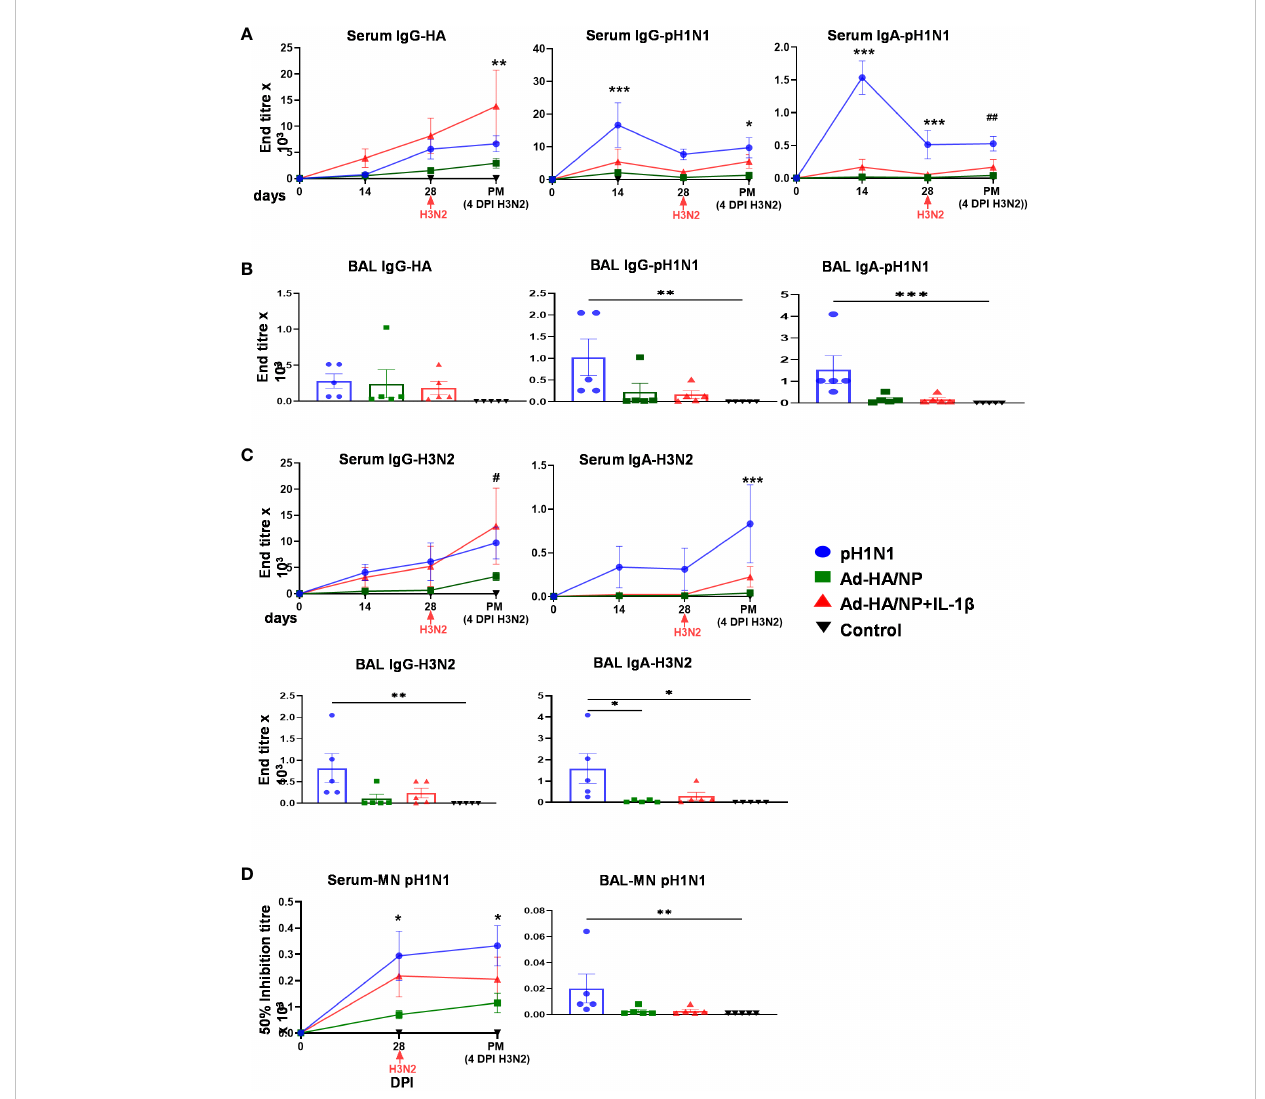
FIGURE 6 Antibody responses against pH1N1 and H3N2. IgG and IgA responses against the HA protein and pH1N1 were assessed in (A) serum at the indicated time points and in (B) post mortem BAL samples. (C) IgG and IgA responses against H3N2 were assessed in serum samples at day 14, 28 and 32 and in BAL samples post mortem. (D) Neutralizing antibody responses against pH1N1 were analyzed in BAL at day 32 and in serum at day 0, 28 and 32. All values represent mean ± SEM of fi ve pigs per group (n=5). Statistical signi fi cances were analyzed by two-way ANOVA followed by Tukey ’ s Multiple Comparison Test for serum samples or Kruskal-Wallis test with Dunn ’ s multiple comparison test for BAL samples. ***, p<0.001 H1N1pdm09 vs. all groups; *, p<0.05 H1N1pdm09 vs. Ad-HA/NP; **, p<0.01 Ad-HA/NP vs. Ad-HA/NP + Ad-IL-1 b ; #, p<0.05 Ad-HA/NP + Ad-IL-1 b vs.